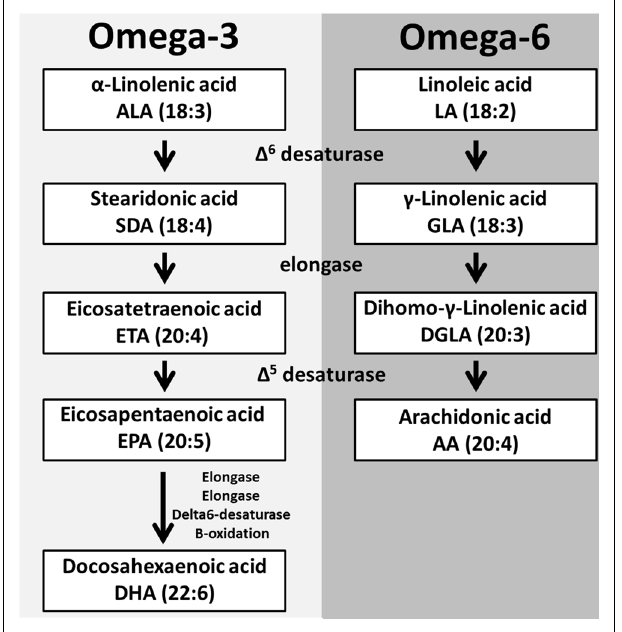
FIGURE 2 | Polyunsaturated fatty acid biosynthesis. The essential fatty acids α -linolenic acid (ALA) and linoleic acid (LA) are metabolized to produce PUFAs.The initial step is the addition of a double bond to both ALA and LA to form the respective desaturated products.These desaturated metabolites are elongated and another desaturase can add a double bond to these elongated products to produce EPA and AA, respectively. EPA through a series of enzymes is converted into